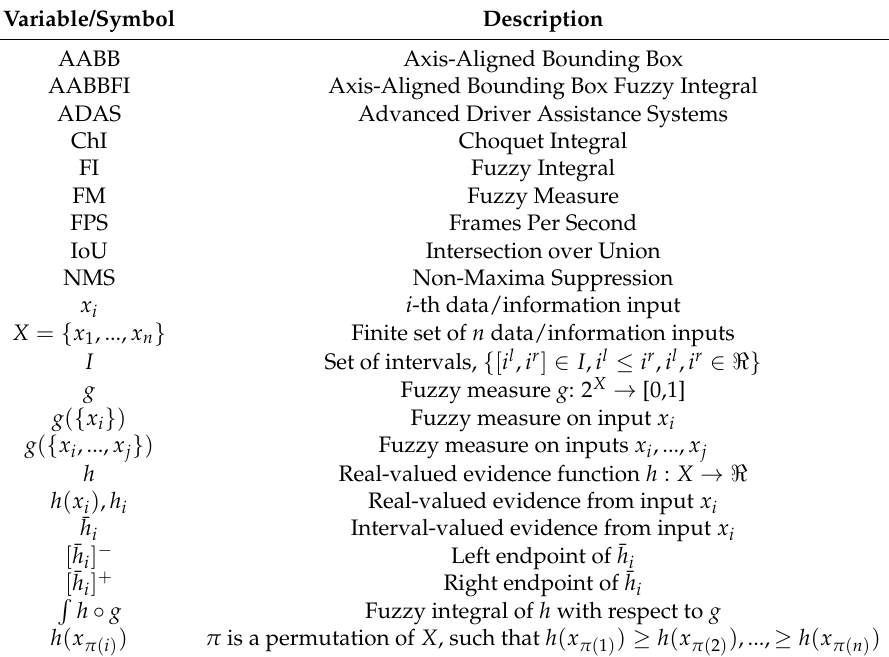
Table 1. Acronyms and mathematical